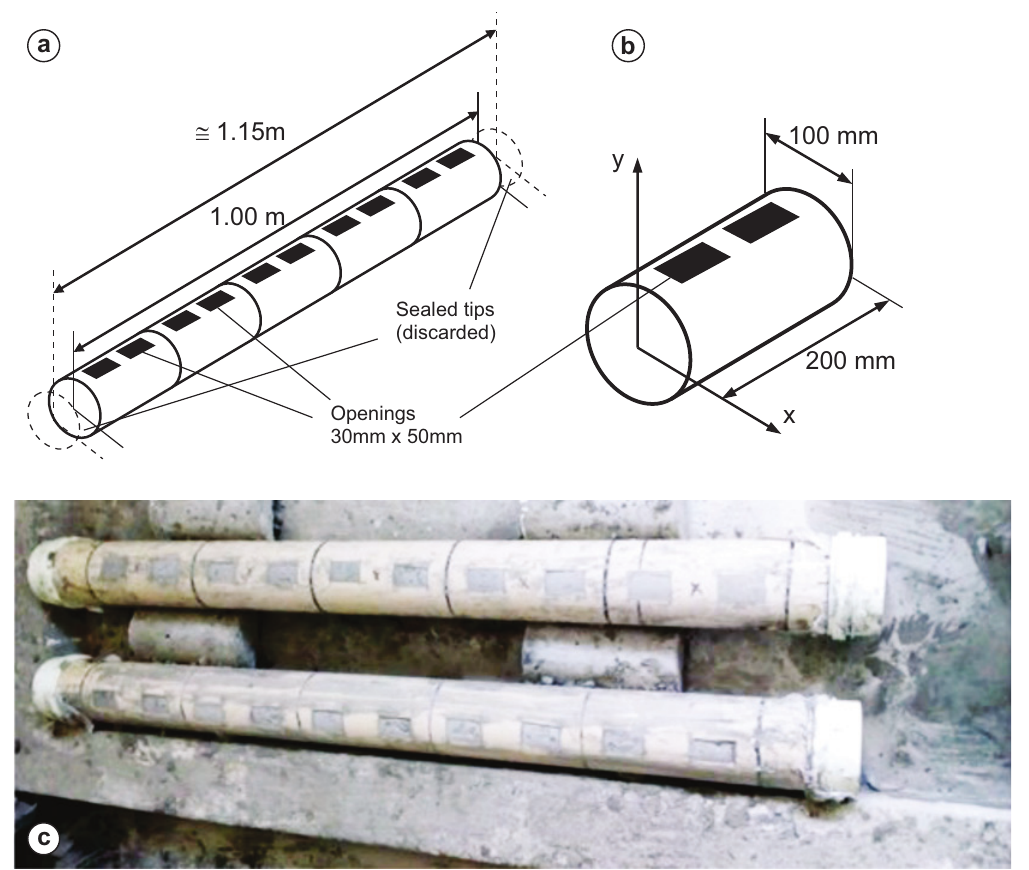
(a) Sketch of PVC pipe employed as mold of the cylindrical horizontal samples, (b) Approximate final dimensions of the test samples, (c) view of the molds after